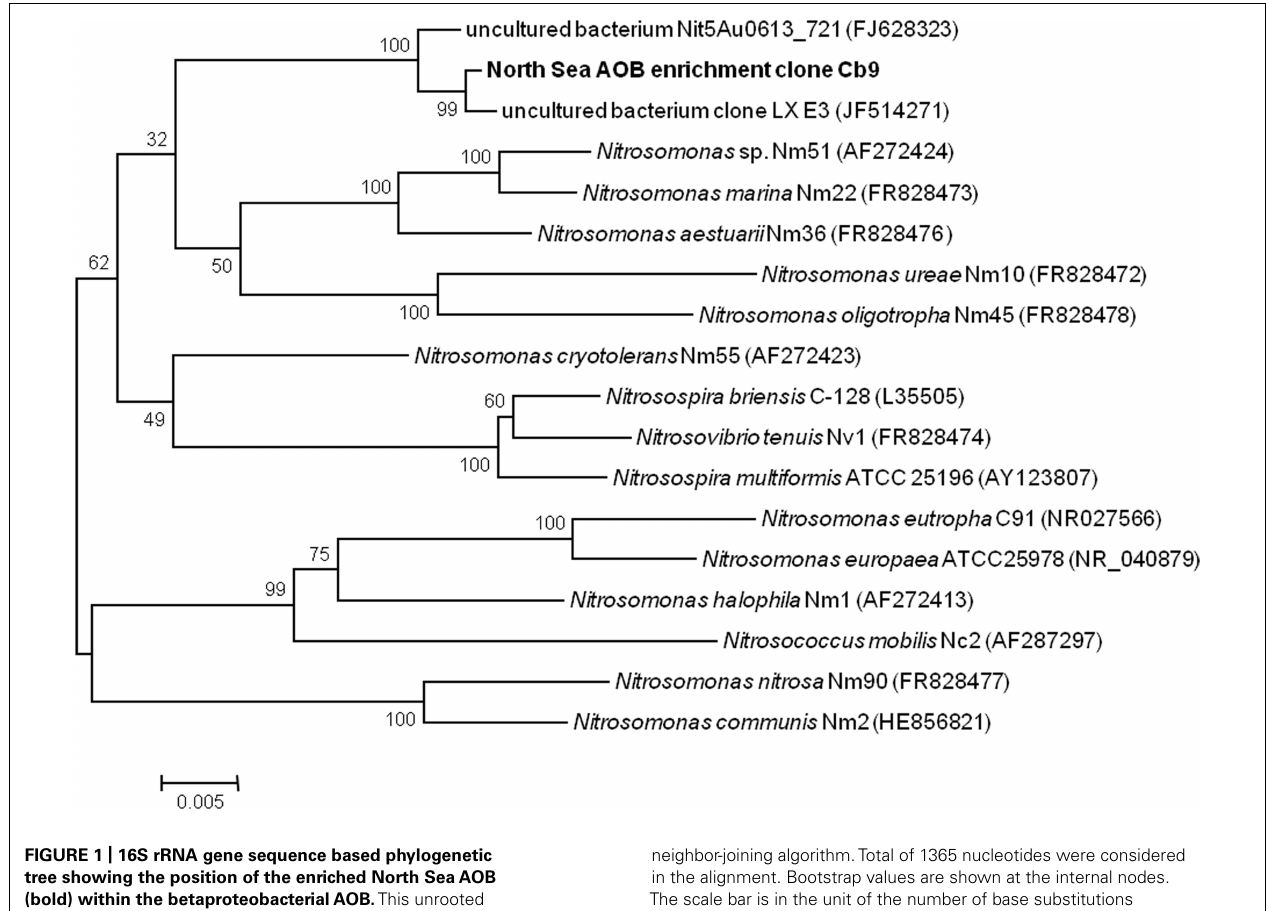
neighbor-joining algorithm.Total of 1365 nucleotides were considered in the alignment. Bootstrap values are shown at the internal nodes. The scale bar is in the unit of the number of base substitutions per